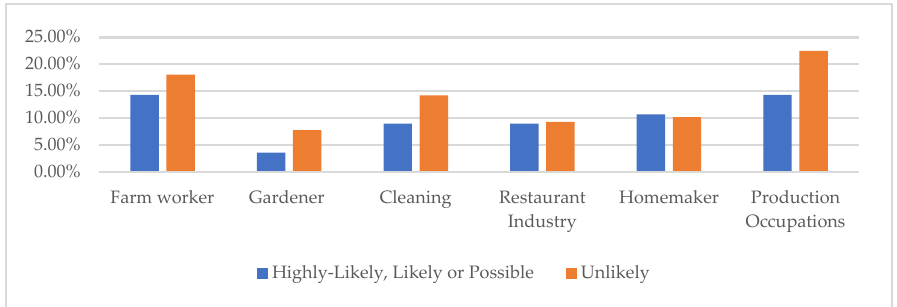
Figure 1. Occupation by HMQ score .